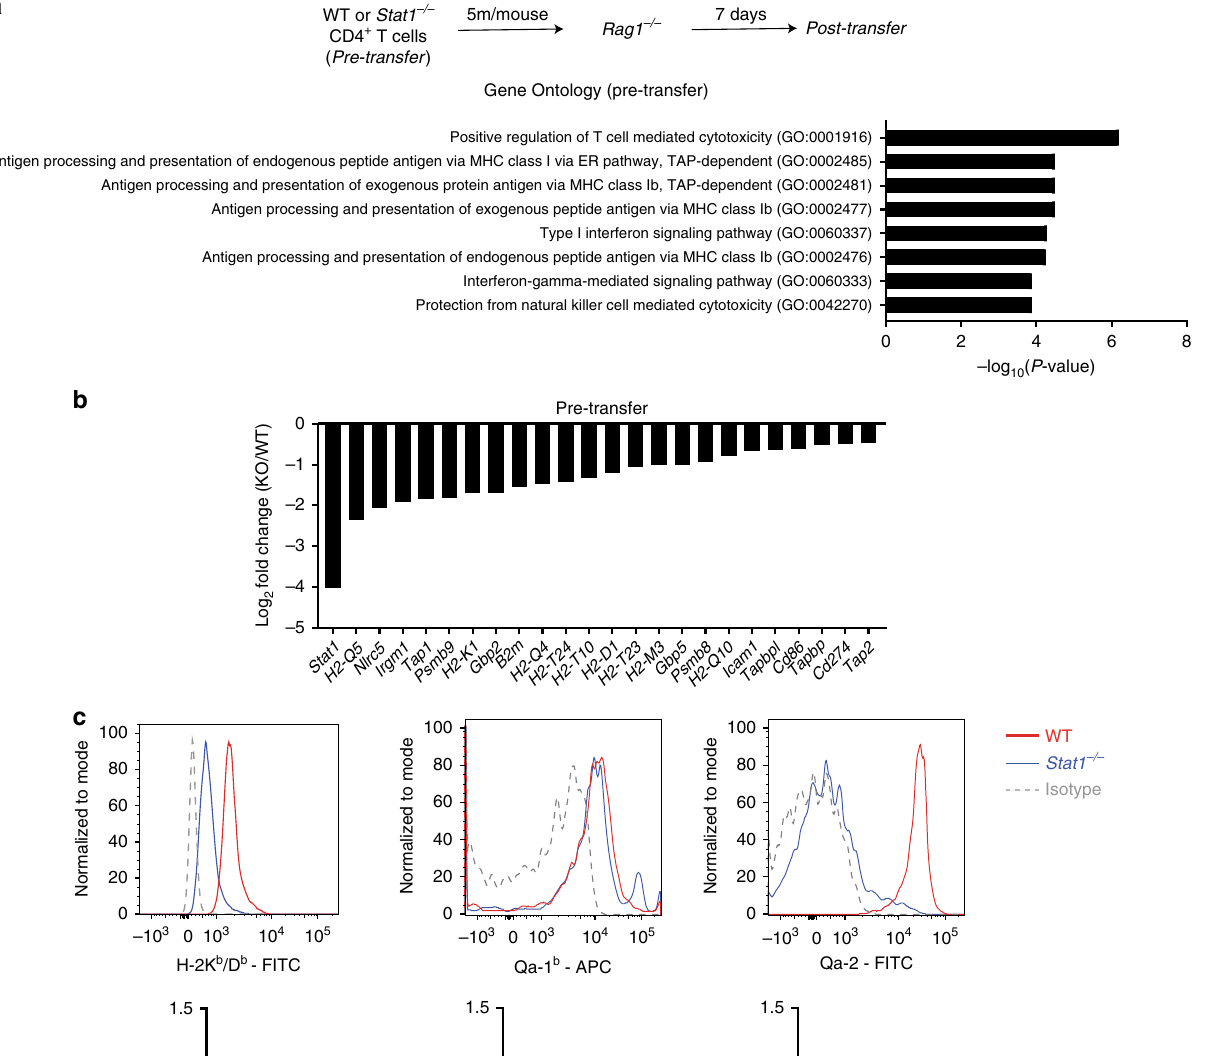
Positive regulation of T cell mediated cytotoxicity (GO:0001916) (GO:0002481)Antigen processing and presentation of endogenous peptide antigen via MHC class I via ER pathway, TAP-dependent (GO:0002485) (GO:0002477)Antigen processing and presentation of exogenous protein antigen via MHC class Ib, TAP-dependent (GO:0060337)Antigen processing and presentation of exogenous peptide antigen via MHC class Ib Type I interferon signaling pathway (GO:0060333)Antigen processing and presentation of endogenous peptide antigen via MHC class Ib (GO:0002476)